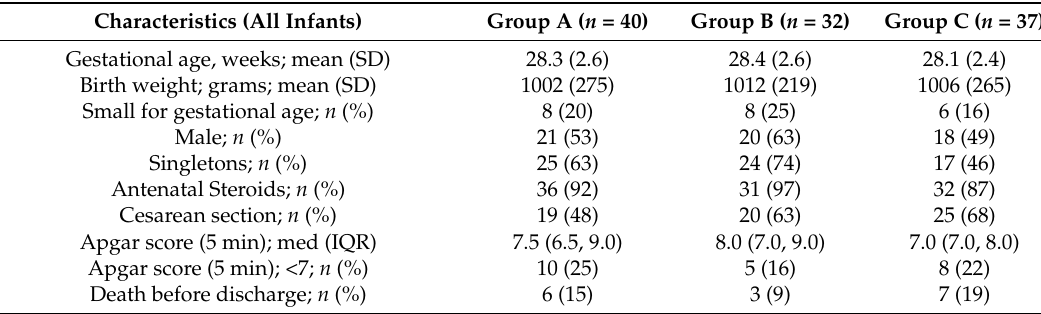
Figure 1. Consort diagram. MOM: mother’s own milk; PFM: preterm formula milk; HM: human milk; TCA: term corrected age; DXA: dual energy X-ray absorptiometry scan. Table 1. Patient characteristics, morbidity, medication.